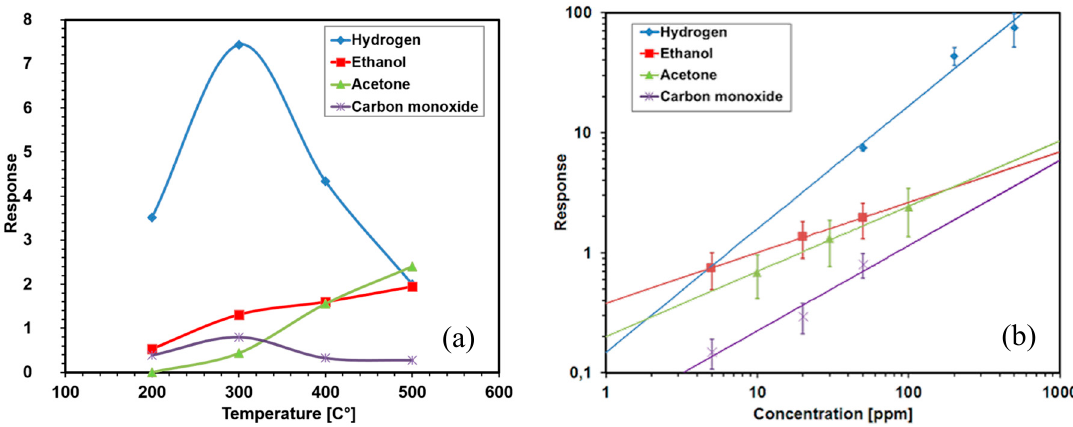
Figure 6. ( a ) Response of NiO nanowires towards some target gases; ( b ) Calibration curves for NiO sensor devices towards hydrogen at 300 °C, acetone and ethanol at 500 °C, and carbon monoxide at 300 °C. Reprint from [64] with permission.